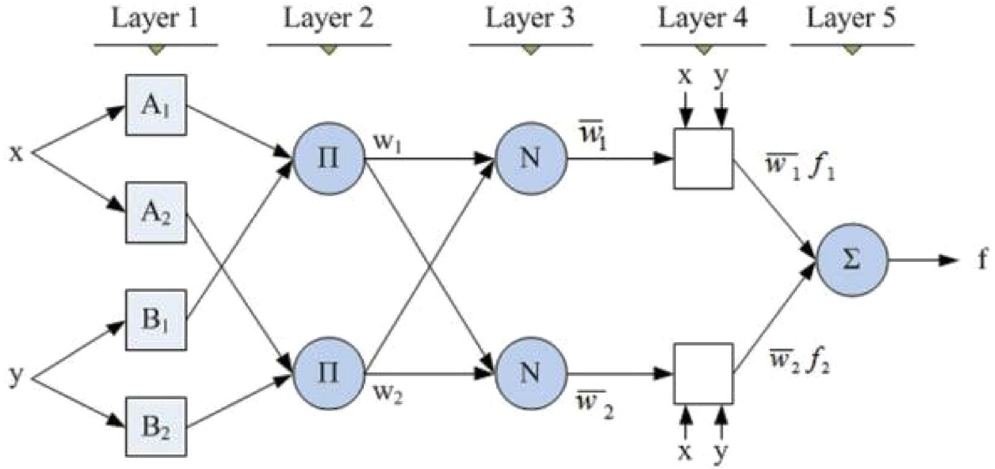
Figure 4. ANFIS network